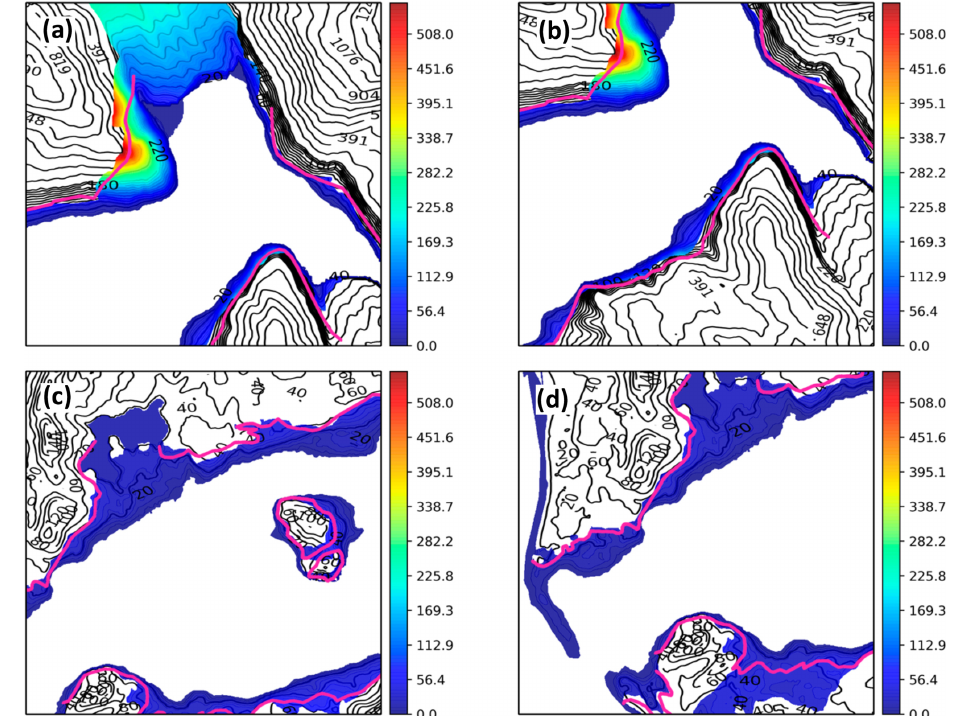
Figure 15. Same as in Fig. 10 but for the blind simulation with standard not optimally adjusted parameters. Comparison with the observed trimline. (a) Gilbert and Crillon inlets. (b) Inner part of Lituya Bay from Cenotaph Island. (c) Fish Lake and Cenotaph Island area. (d) En- trance of the bay up to Cenotaph